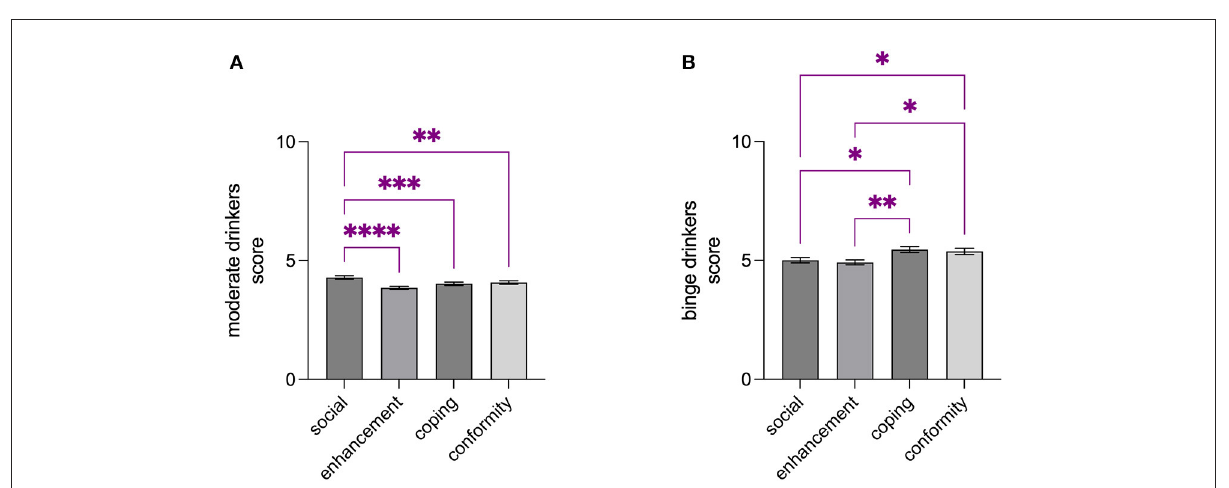
FIGURE1 Drinking motives differently characterized moderate- and binge drinkers. Social motive score was found to be higher than enhancement-, coping-, and conformity scores among moderate drinkers (A) , while coping and conformity motive scores were found to be higher than social- and enhancement scores (B) . Data are shown as the mean ± SEM. * p < 0.05; ** p < 0.01; *** p < 0.001; **** p <